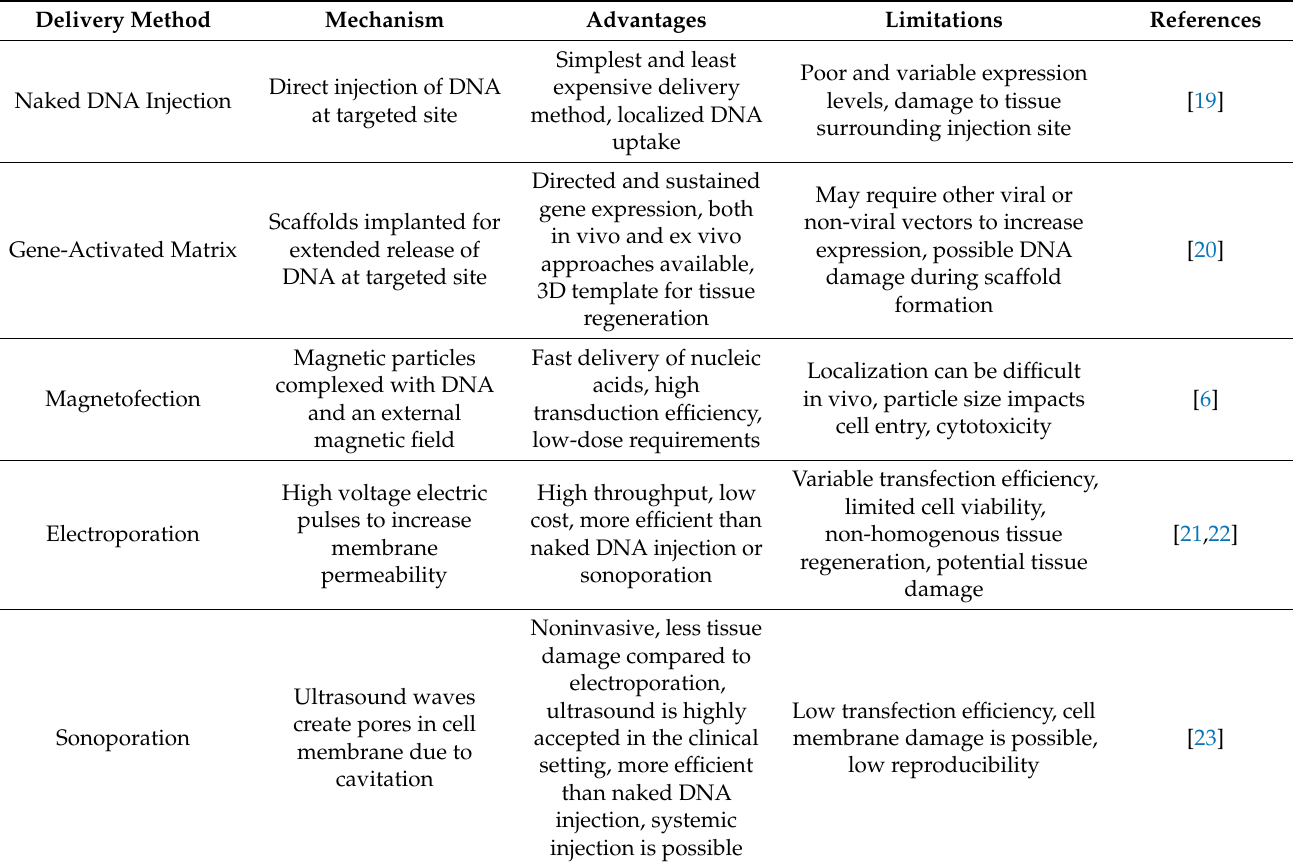
Table 1. Advantages and disadvantages of non-viral gene delivery